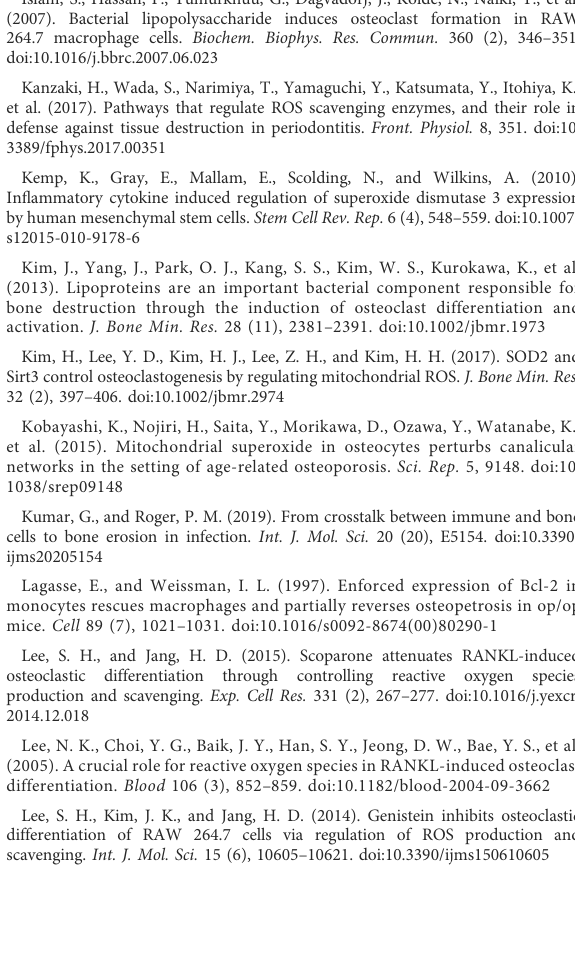
Representative images of immuno fl uorescence for in fl ammatory factors in murine calvaria. (A-C) The protein expression of pro-in fl ammatory factors of TNF- α , IL1- β , and IL-6 was stimulated by LPS while downregulated by BNTA. (D) The protein expression of in fl ammatory inhibitory factors of IL-4 did not present signi fi cant change with the stimulation of LPS or treatment of BNTA. Red fl uorescence